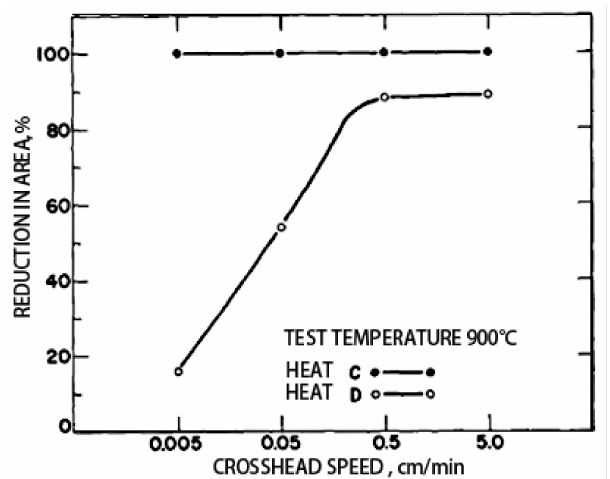
Figure 15. Effect of crosshead speed on the reduction of area at 900 ◦ C for C-Mn steel heats C and D. Reprinted with permission from ref. [16]. Copyright 1969 Springer